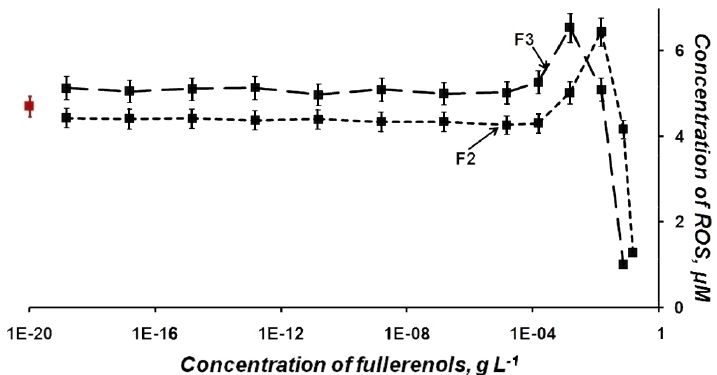
Figure 6. Concentration of ROS vs. concentrations of fullerenols F2 and F3 for the chemiluminescence assay. Content of ROS in distilled water is indicated by a red point in the left part of figure.